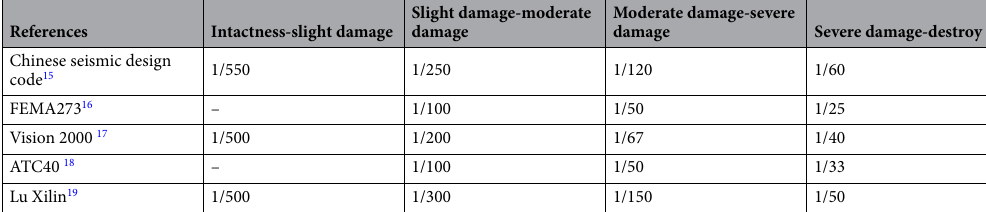
Table 1. Seismic damage classification standard of reinforced concrete frame